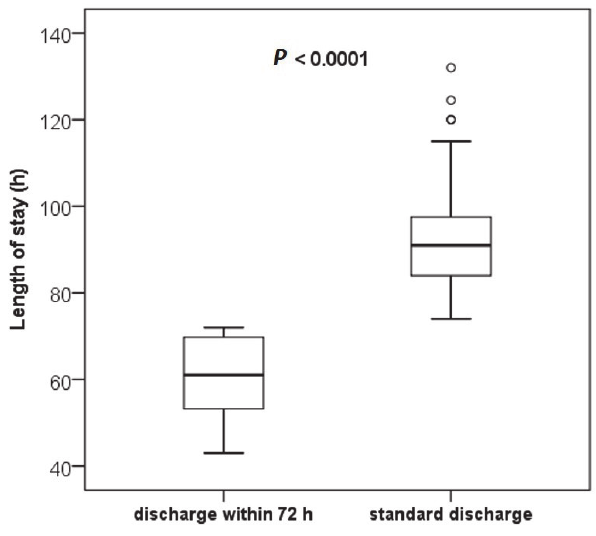
Fig. 3. Distribution of length of stay in compared